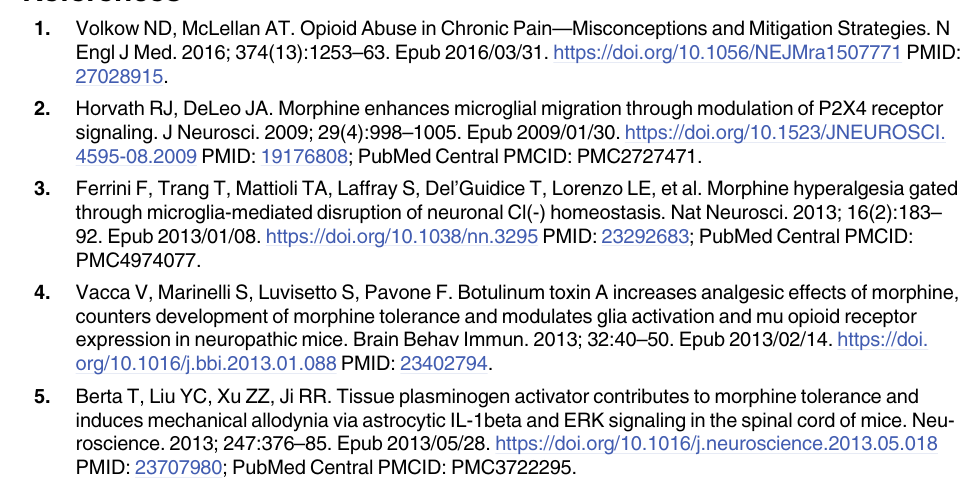
S1 Fig. The expression of CD11b in BV2 microglia treated with AG1478. (a) BV-2 cells were treated with DMSO, AG1478 (2.5, 5, and 10 μ M), morphine (200 μ M), and AG1478 (2.5, 5, and 10 μ M) + morphine (200 μ M) for 6 h and tested by immunocytochemistry staining (red fuorescence; × 200 magnifcation). (b) The mean optical densities of six randomly selected fields of cells from each group were analyzed by ImageJ software for quantitative analysis. Data are expressed as the means ± SEMs. All data were analyzed using ANOVA. � p < 0.05 and �� p < 0.01 compared to the DMSO group. # p < 0.05 and ## p < 0.01 compared to morphine